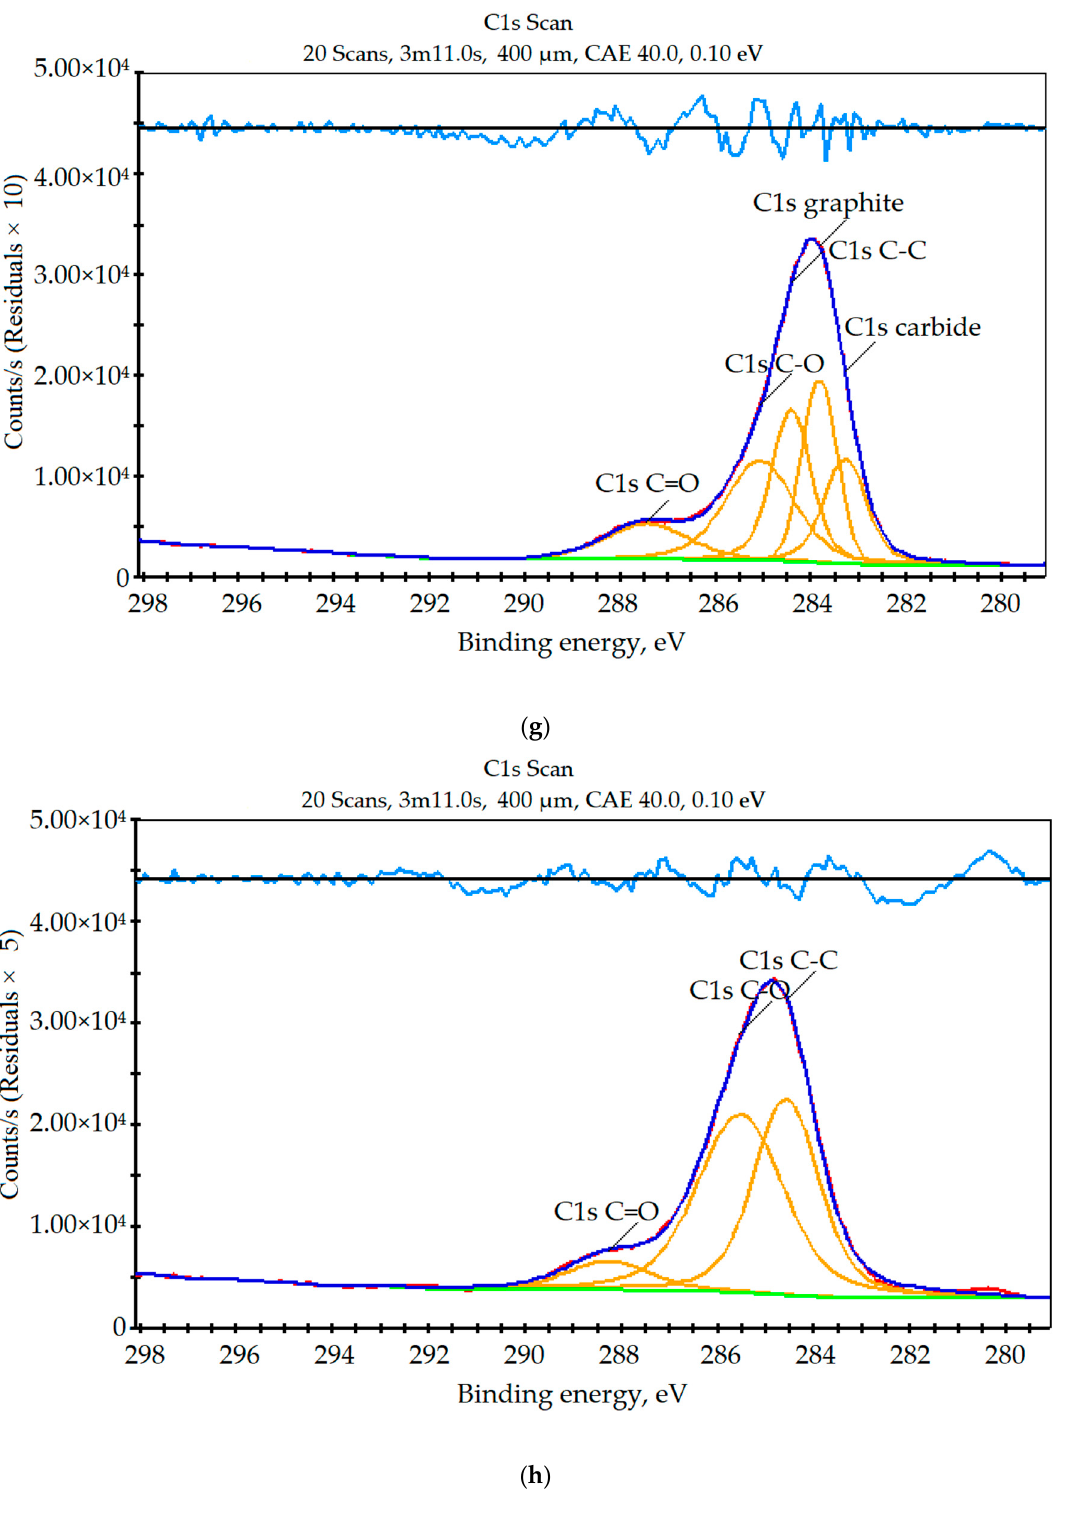
Figure 12. X-ray photoelectron spectroscopy of the Al 2 O 3 + 30%TiC nanocomposite cross-section after machining: ( a ) Aluminum content, in oil; ( b ) Aluminum content, in water; ( c ) Oxygen content, in oil; ( d ) Oxygen content, in water; ( e ) Titanium content, in oil; ( f ) Titanium content, in water; ( g ) Carbon content, in oil; ( h ) Carbon content, in water.